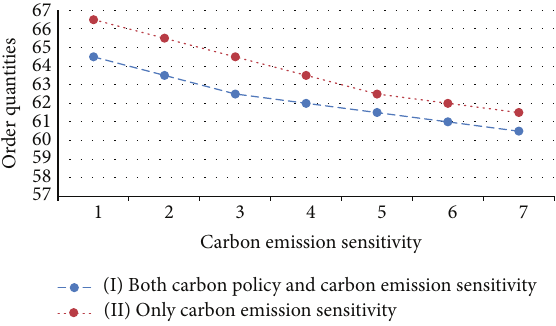
Figure 4: Effect of carbon trade price on retail prices.